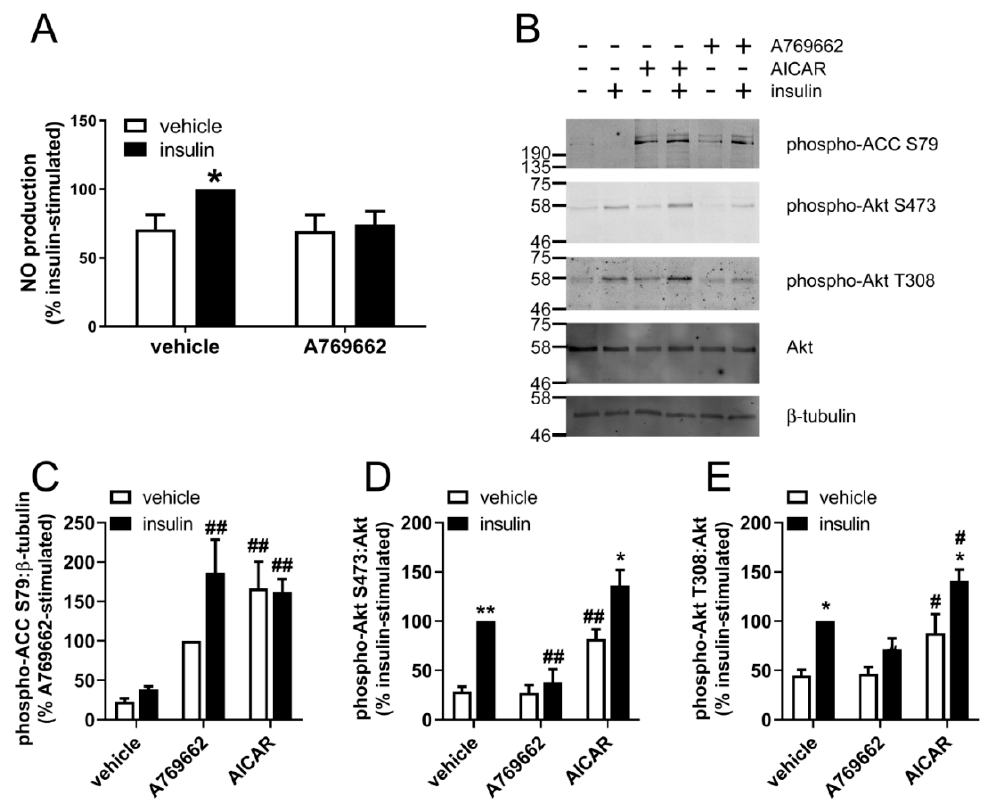
Figure 1. The effect of A769662 on insulin-stimulated NO production and Akt phosphorylation in HUVECs. ( A ) HUVECs were stimulated with A769662 (50 µ M, 45 min) prior to insulin (1 µ M, 15 min), conditioned media collected and NO production assessed. Data (mean ± SEM) shown from three independent replicates. ( B – E ) HUVECs were stimulated with A769662 (50 µ M, 45 min) or AICAR (2 mM, 45 min) prior to insulin (51 µ M, 15 min) and cell lysates prepared. Proteins were resolved by SDS-PAGE and immunoblotted with the antibodies indicated. ( B ) Representative immunoblots from three biological replicates with molecular weight markers indicated. Phospho-Akt Thr308 protein levels were assessed by stripping and re-probing the membranes. Densitometric quantification of ( C ) ACC, ( D ) Akt Ser473 and ( E ) Akt Thr308 phosphorylation normalised to β -tubulin or Akt (mean ± SEM). * p < 0.05, ** p < 0.01, relative to absence of insulin. # p < 0.05, ## p <0.01 relative to absence of AMPK activator.